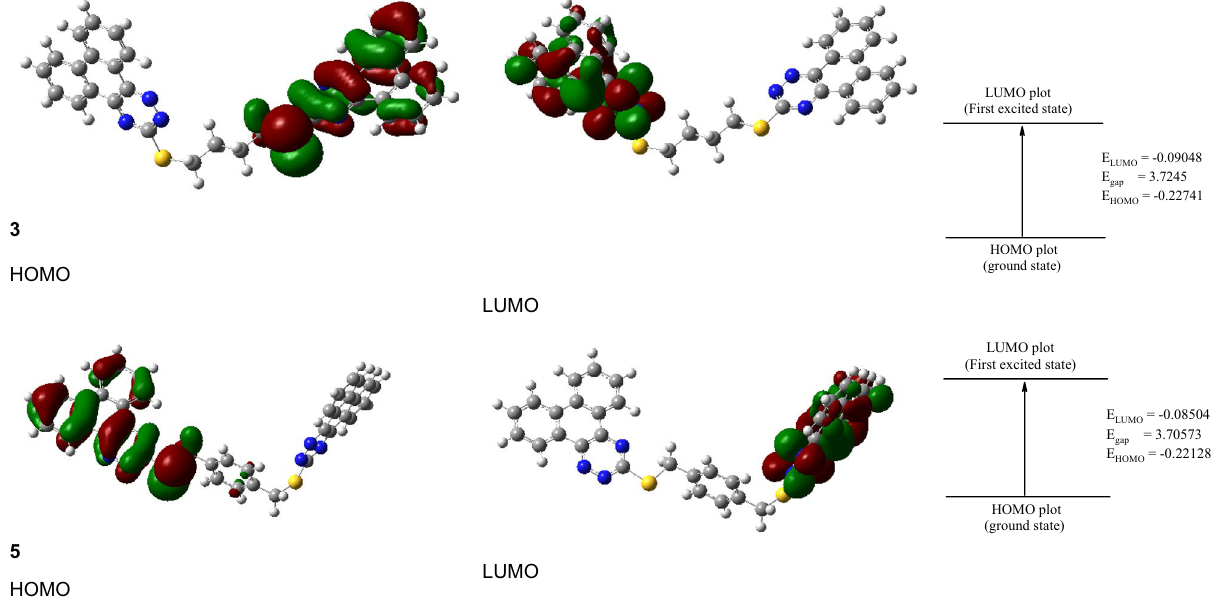
Figure 3. HOMO and LUMO charge density maps of the studied 3 and 5 using B3LYP/6-311G**